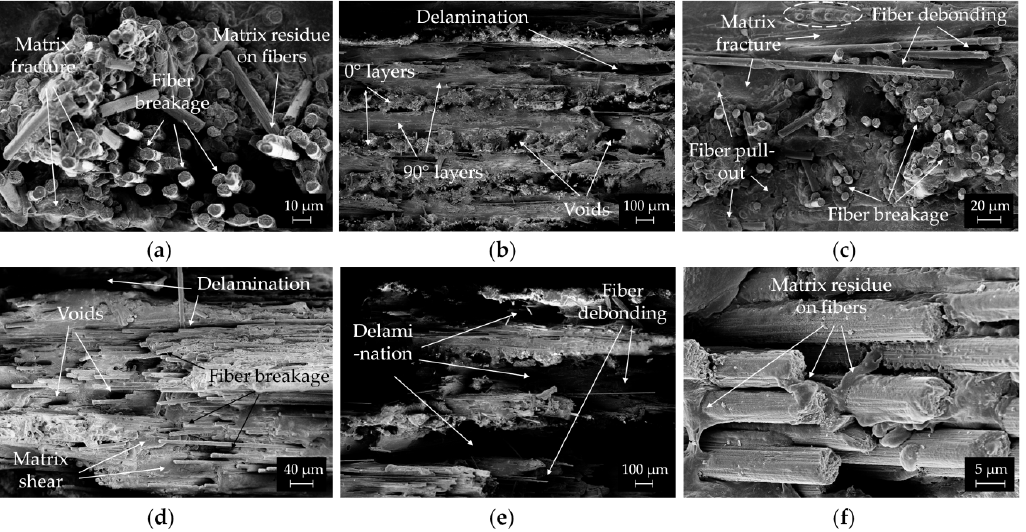
Figure 11. FESEM micrographs of the fracture surfaces of ( a ) [0], ( b , c ) [0/90] s , ( d ) [0/45/90/ − 45] s and ( e , f ) [0/ ± 60] s CCF/PA composites. The mechanisms of fiber breakage, pull-out and debonding, matrix fracture and layers delamination are outlined in the images.